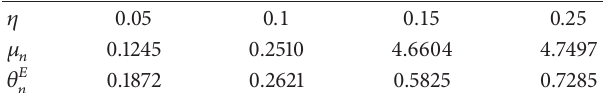
Table 3: Einstein rings and magnifications ( 𝑛 = 1 ) for phantom global monopole.